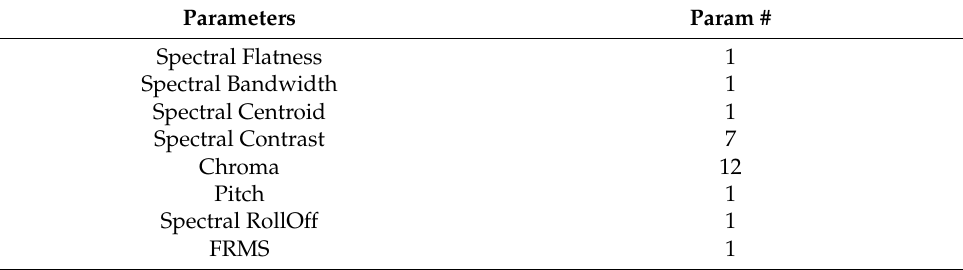
Table 1. 25 parameters belonging to set